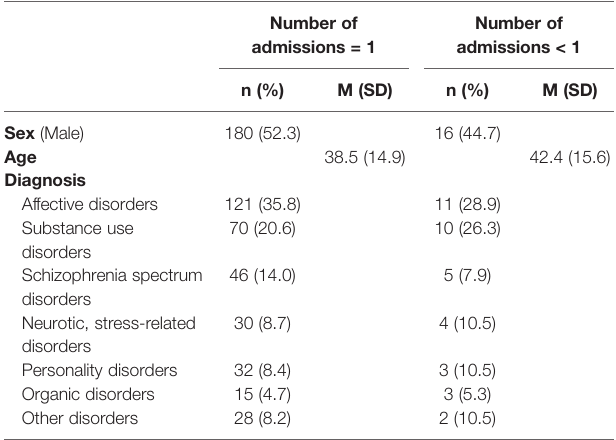
TABLE 1 | Characteristics of included participants admitted once (n = 342) and several times (n = 38) in the study